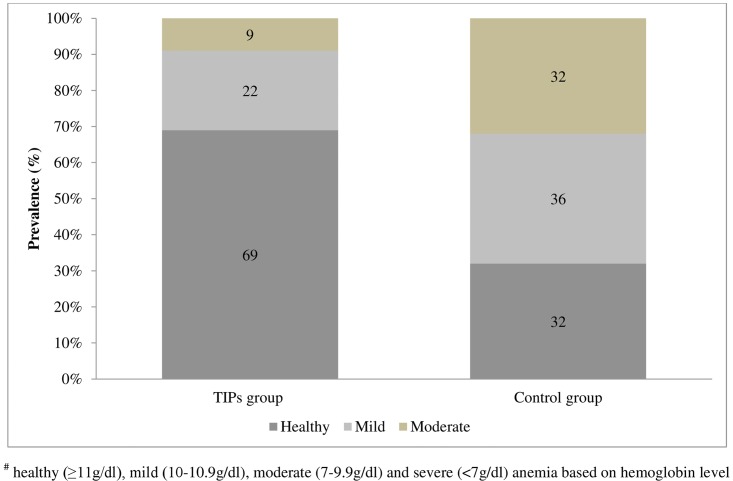
Percentage prevalence of anemia in both the study groups after the TIPs intervention.Hemoglobin level cut-offs: healthy (≥11g/dl), mild (10–10.9g/dl), moderate (7–9.9g/dl) and severe (<7g/dl) anemia